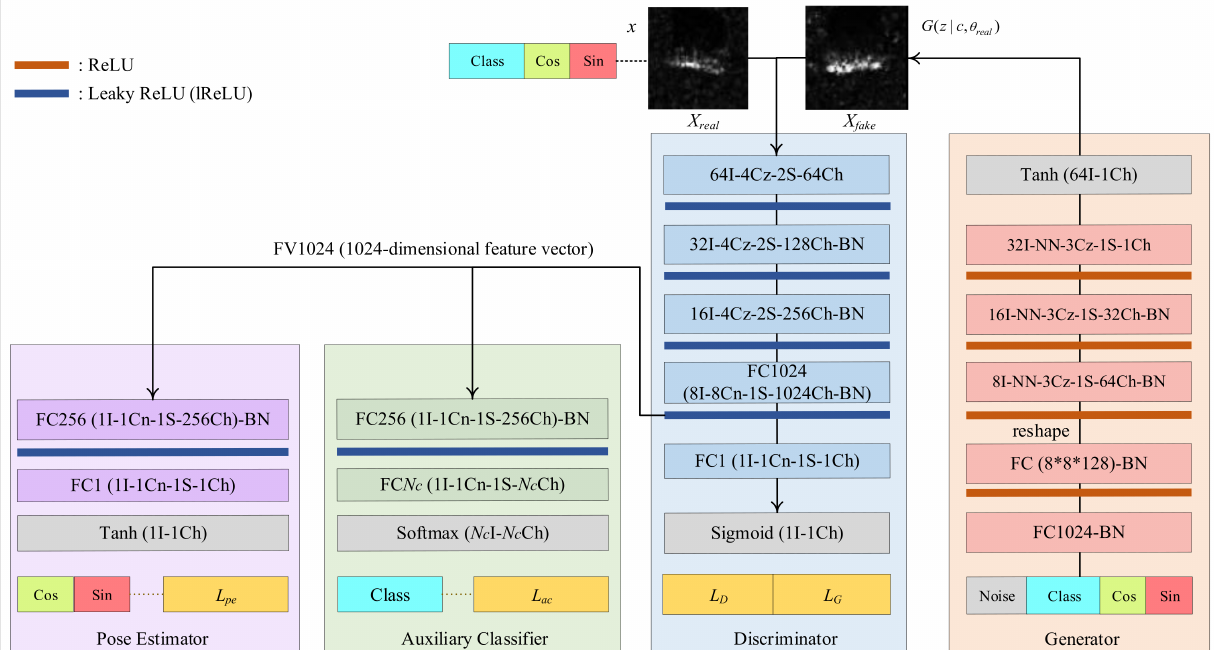
Figure 2. An overall structure of PeaceGAN. PeaceGAN is in essence composed of a discriminator and generator. The generator takes a concatenated input vector of a random noise vector, a target class vector, and a pose angle vector. In addition, the discriminator of PeaceGAN additionally has two newly introduced structures: (i) a pose estimator that is trained to estimate the pose angle values of SAR images in terms of both cosine and sine functions, and (ii) an auxiliary classifier that is trained to determine which target classes the SAR images belong to. Note that a convolution layer with v I- w Cz- x S- y Ch indicates having a v × v -sized input, a w × w -sized convolution filter with zero padding, an x × x -sized stride, and y output channels. In addition, w Cn indicates a w × w -sized convolution filter without zero padding, NN means nearest-neighborhood upsampling with scale 2, BN means batch normalization, and FC y means a fully connected layer with output channel size y